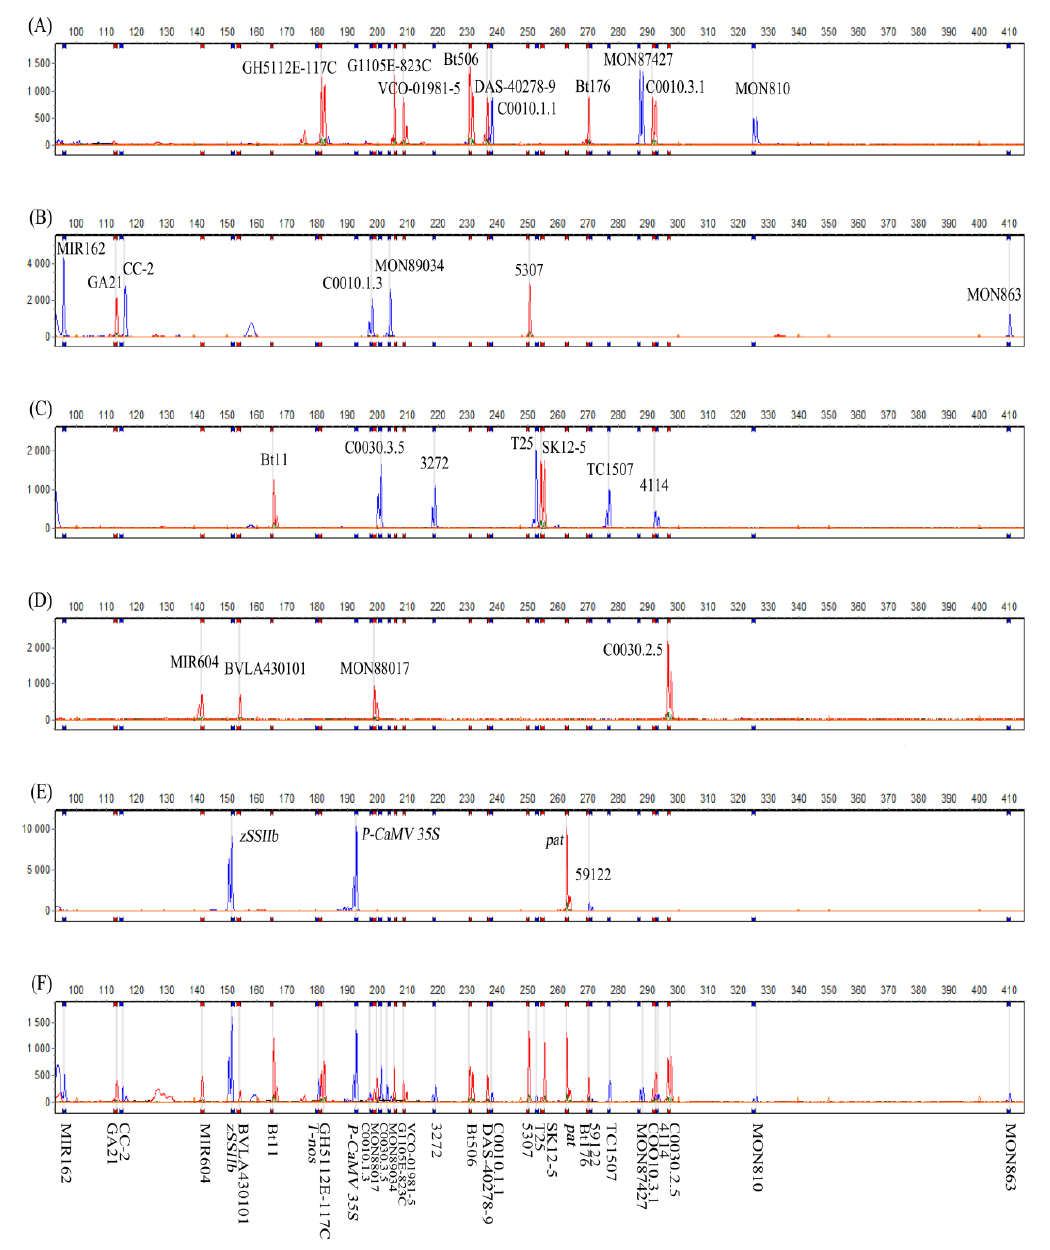
Figure 2. Results of combined capillary electrophoretic analyses of products of five multiplex PCR panel assays. The x- and y-axes represent amplified fragment length and fluorescence intensity, respectively. ( A – E ) Capillary electrophoretograms from multiplex PCR assays of panels i to v, respectively. ( F ) Capillary electrophoretogram of combined products from all five assays (mixed 33-plex electrophoresis). Table 1. Results of limit-of-detection analysis.